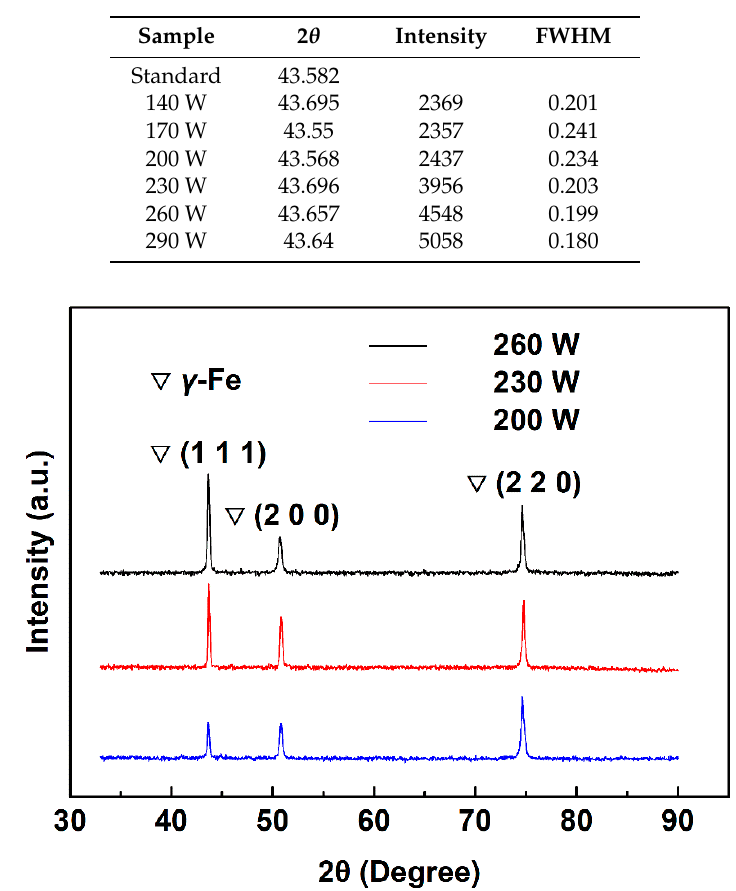
Table 2. XRD (X-ray diffraction) data of 2 θ , intensity and peak FWHM (full width at half maximum) of the peak at crystal plane (111).